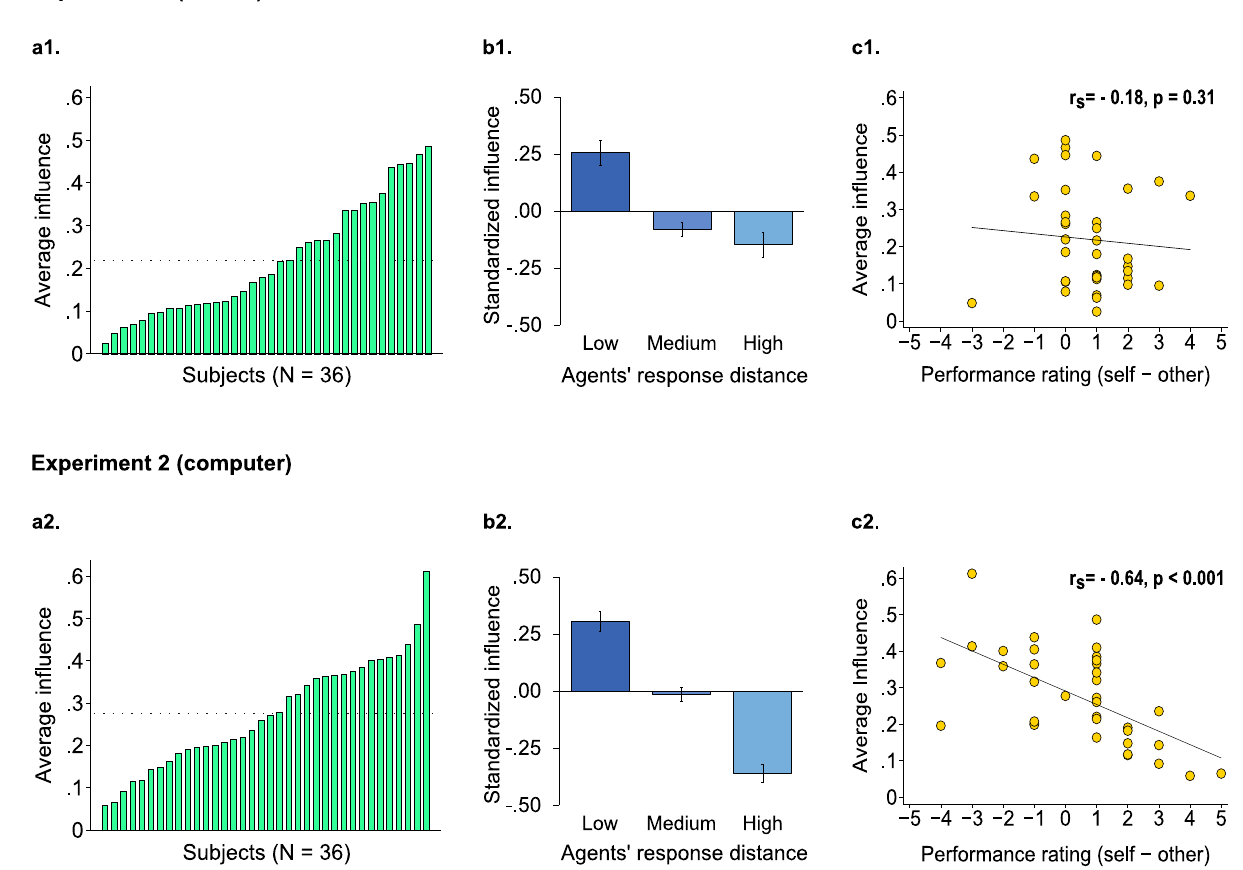
Figure 3. Results of the Social influence task in Experiment 1 ( a1 , b1 , c1 ) and Experiment 2 ( a2 , b2 , c2 ). In Experiment 1, participants believed to be interacting with a human partner, while in Experiment 2 they were aware of interacting with a computer. The partner’s responses were identical across experiments. ( a1 , a2 ) Average influence (i.e., shift towards the partner’s response in the final decision) plotted across participants in Experiment 1 and Experiment 2, respectively. ( b1 , b2) Standardized influence plotted as a function of agents’ response distance. To obtain this graph, for each participant, we standardized trial-by-trial normalized distance between the estimates of the two agents [distance (cm)/stimulus length (cm)] to express each distance value in terms of deviation from the individual subject mean. We clustered standardized distances in three bins: low (distance < − 0.5 SD); medium (− 0.5 SD ≥ distance < 0.5 SD); high (distance ≥ 0.5 SD). We also standardized, for each participant, trial-by-trial influence to express influence values in terms of deviation from individual influence means. Eventually, for each distance range, we averaged individual influence means across subjects. Error bars represent between-subject standard errors. ( c1 , c2 ) Scatter plot of individual average influence as a function of the difference between self and partner rating of perceptual inference accuracy, assessed at the end of the Social influence task in both experiments. The two measures are not correlated in Experiment 1, whereas we found a strong correlation in Experiment